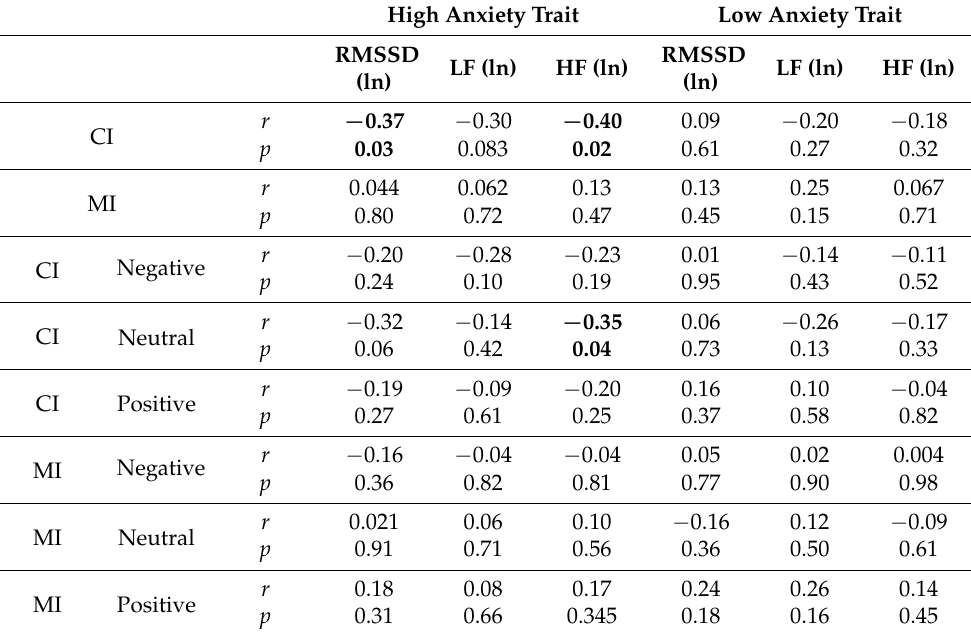
Table 4. Pearson’s r correlation between heart rate variability (HRV) indices and RTs in the flicker task considering the two groups of